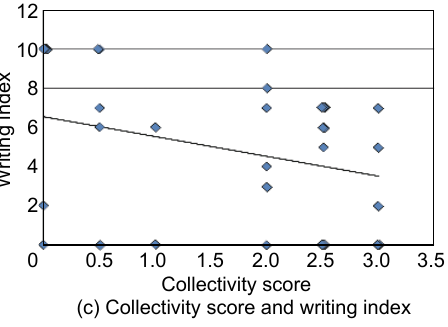
Fig. 9 Governance and writing